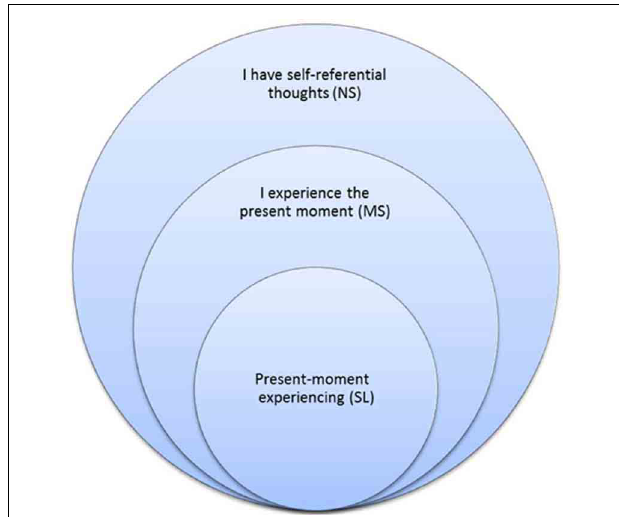
FIGURE 1 | Working model of self-awareness modes. NS, MS and SL as encapsulated processing